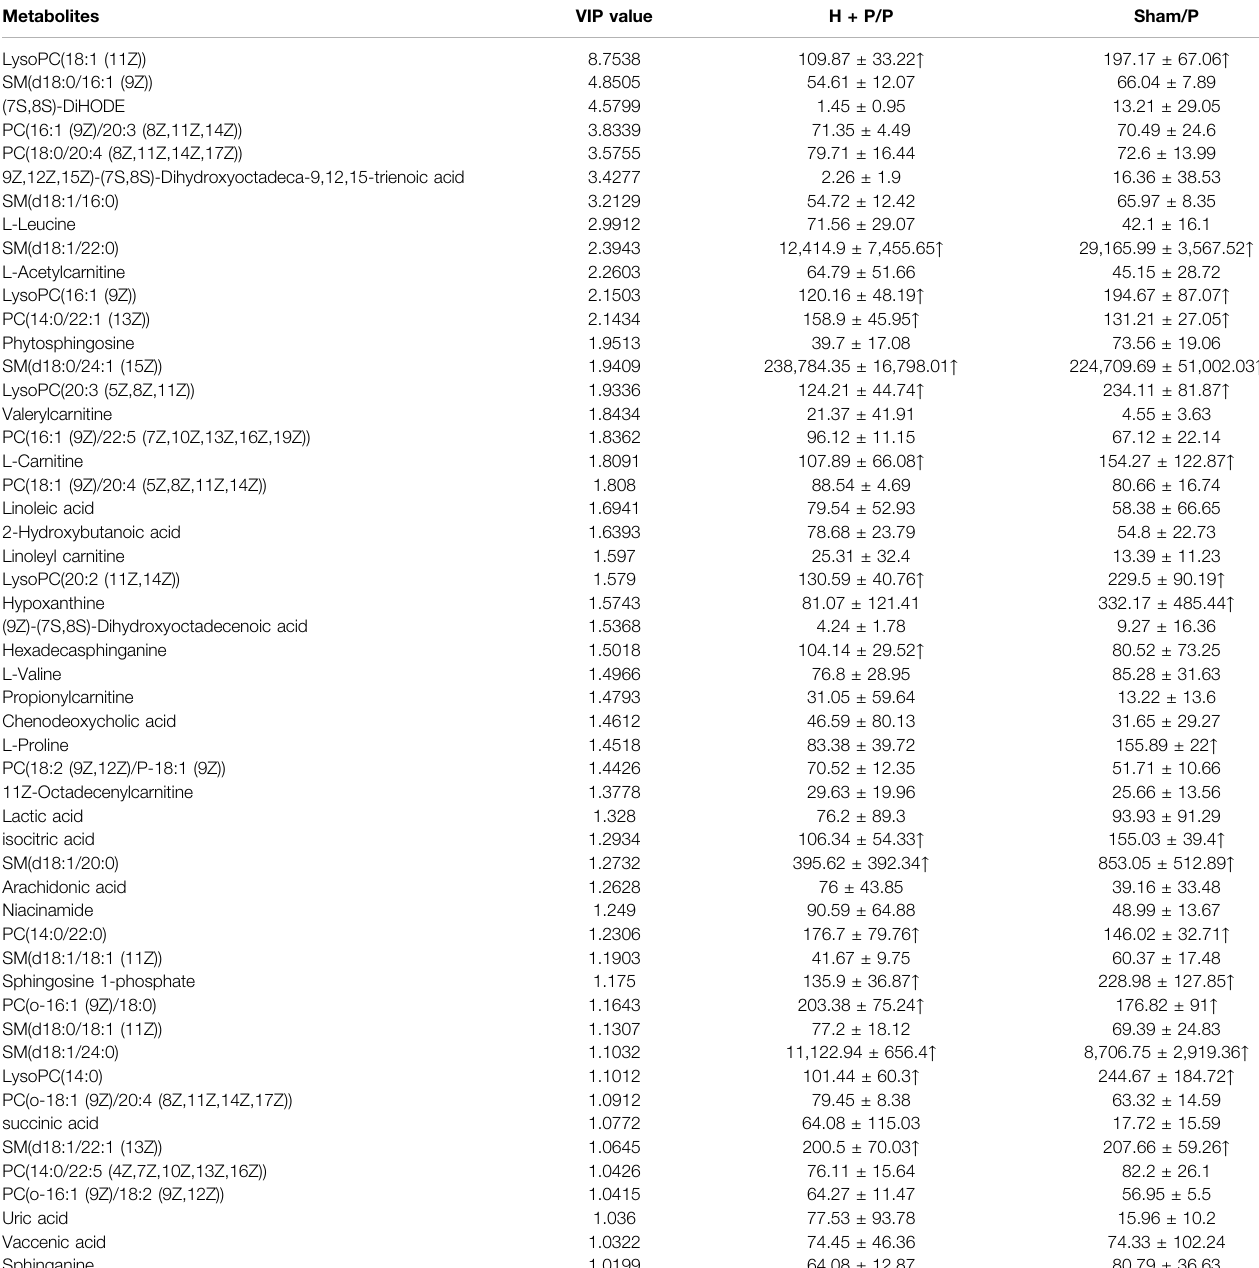
Arrow indicates signi fi cantly up-regulated, but no arrow down-regulated metabolites in the H + P and sham groups compared with P group, each group n = 6.